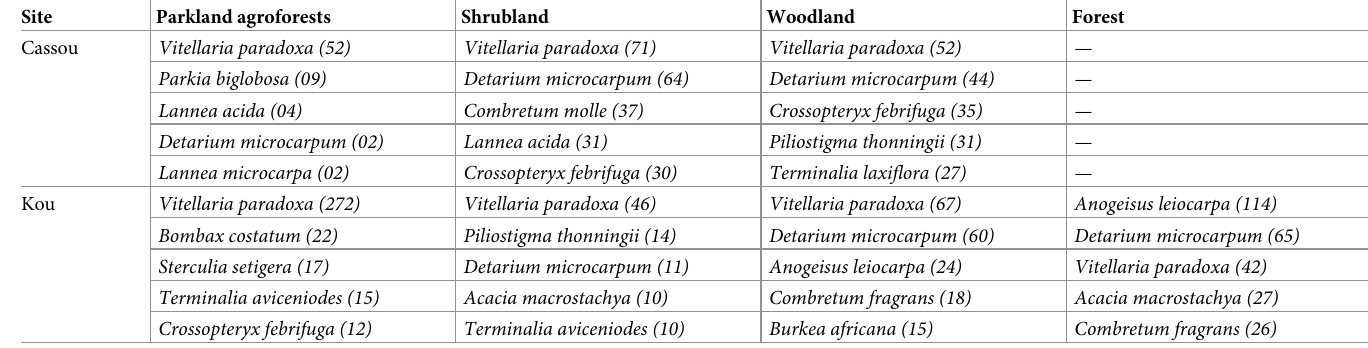
Table 7. Top five dominant woody species per land use and land cover category in Cassou and Kou in Ziro province of Burkina Faso (values in parentheses are the number of individuals).